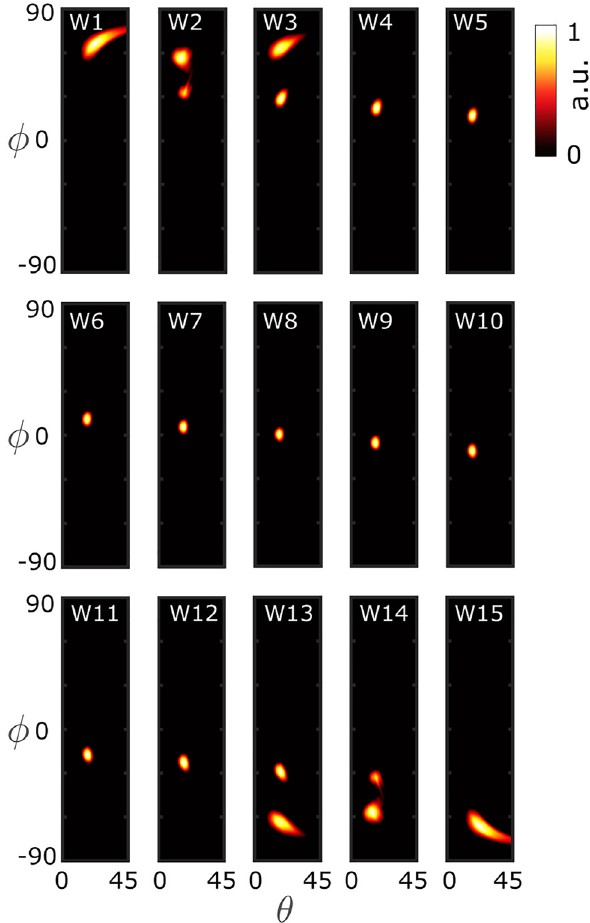
Figure 3: Simulated results of the radiated far-field beam intensity profile of a 15-channel arrayed waveguide lens when excited from different sites. Here, we considered an array of 15 standard SOI ridge waveguides of width 𝑤 = 400 nm and height h = 220 nm, at = 1550 nm. The designed the telecommunication wavelength 𝜆 0 integrated grating coupler has a pitch of Λ = 0.9 um, and is composed of 13 unit cells. In each panel the beam intensity is normalized to its maximum